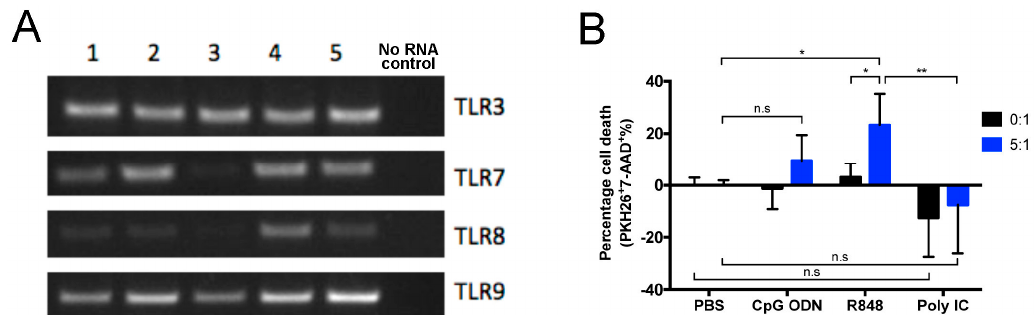
Figure 1. TLR expression and response by E μ -ret mouse-derived primary leukemia cells. ( A ) mRNA from B-ALL cells from five leukemic E μ -ret mice (1–5) was analyzed for the expression of transcripts for TLRs 3 and 7–9 by qualitative RT-PCR. ( B ) Cytotoxic effects of endosomal TLR stimulation on primary B-ALL cells cultured in the absence (0:1) or presence (5:1) of splenocytes from wild-type BALB/c mice. Results shown are pooled from four independent experiments. Two-way ANOVA with Tukey’s multiple comparisons test, bars represent mean ± SD; * p < 0.05, ** p < 0.01, n.s = not significant.